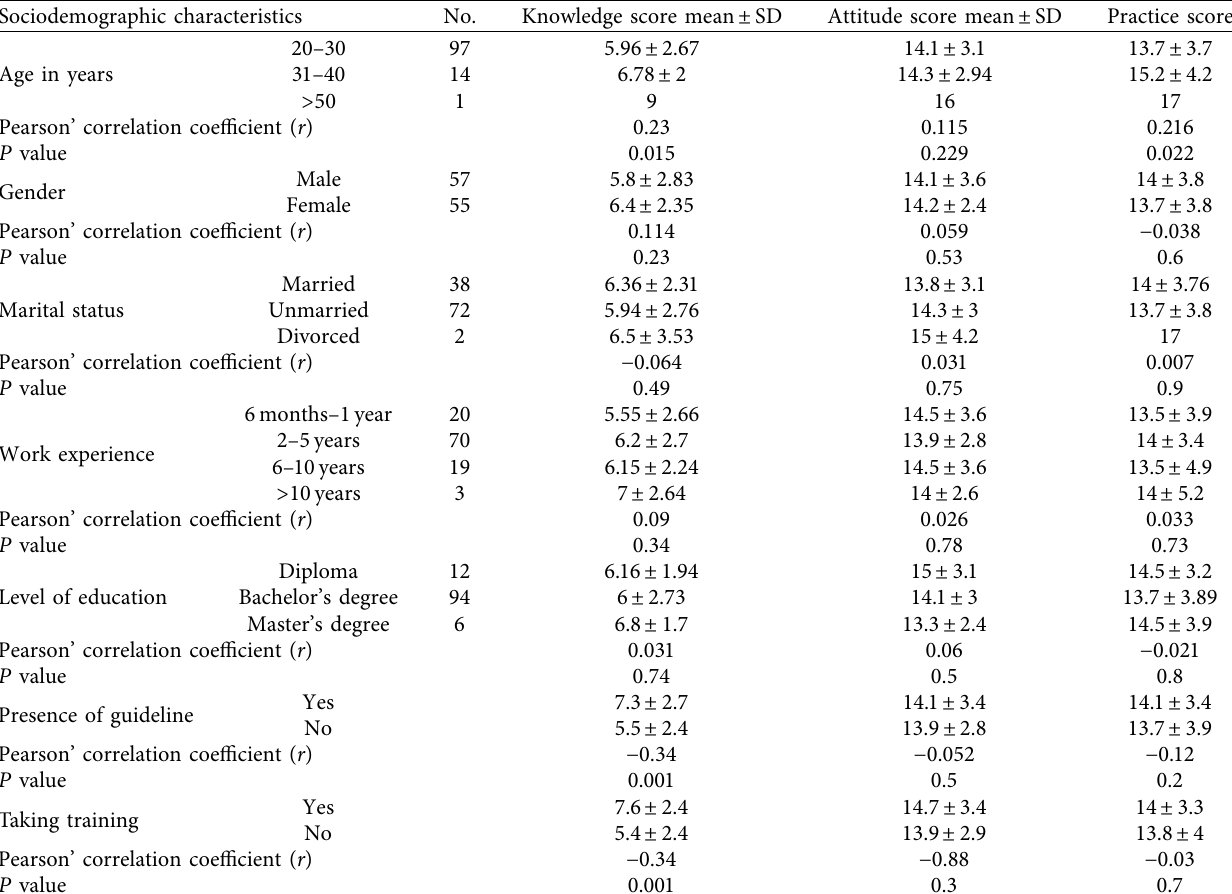
Table 5: Association of demographic characteristics with participant nurses’ knowledge, attitude, and practice in Pearson’s correlation coefficient analysis ( n � 112).